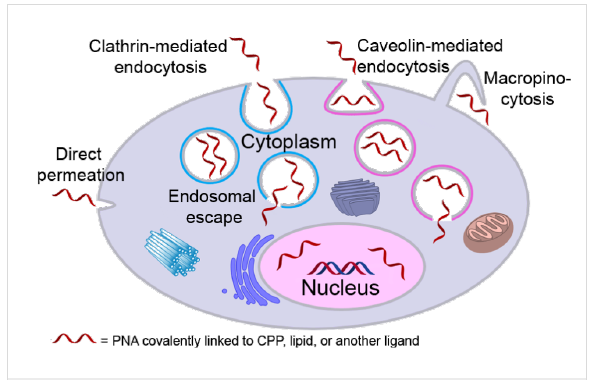
Figure 11: Endosomal entrapment and escape pathways of PNA and PNA conjugates.